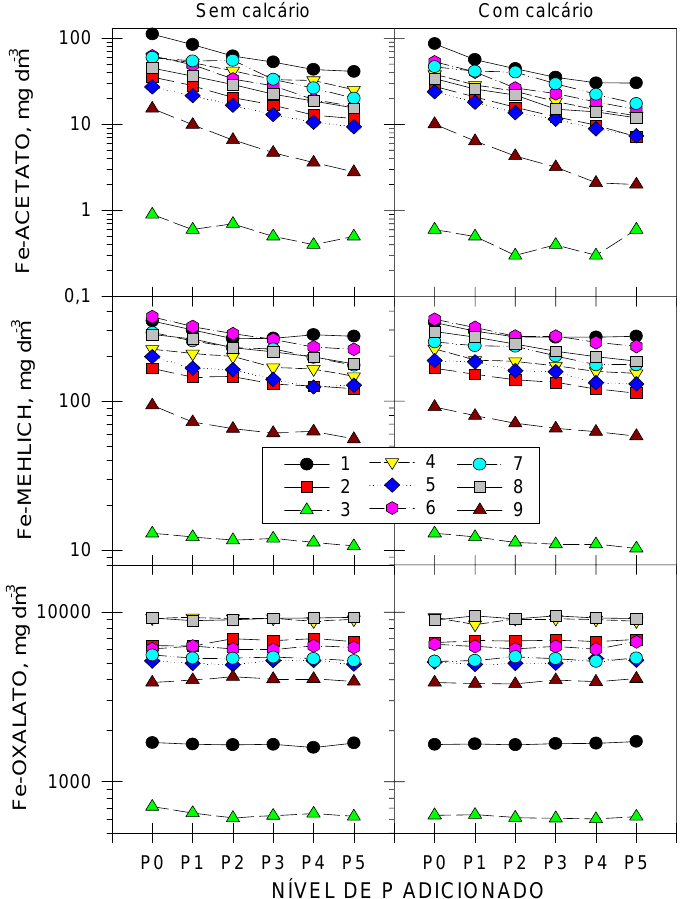
Figura 1. Teores de Fe em amostras de nove solos de várzeas, submetidos a seis doses de fósforo na presença e ausência de